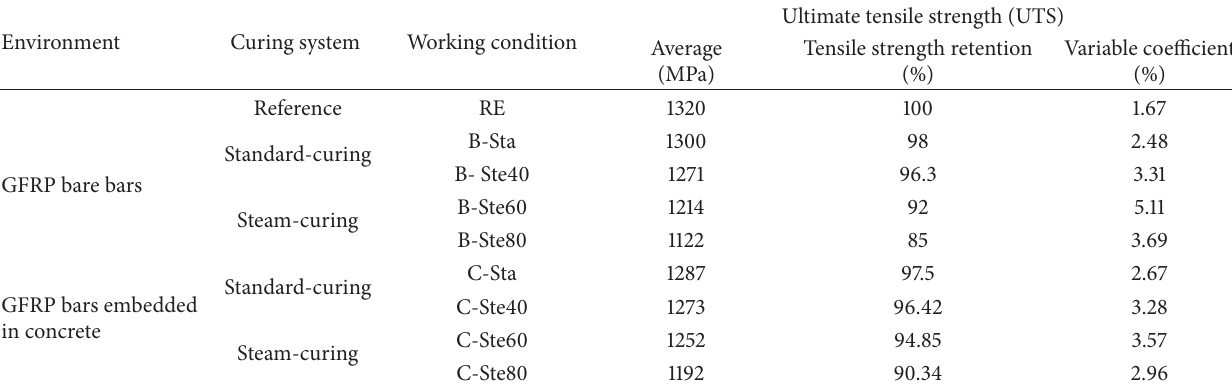
Table 2: Tensile test results of GFRP